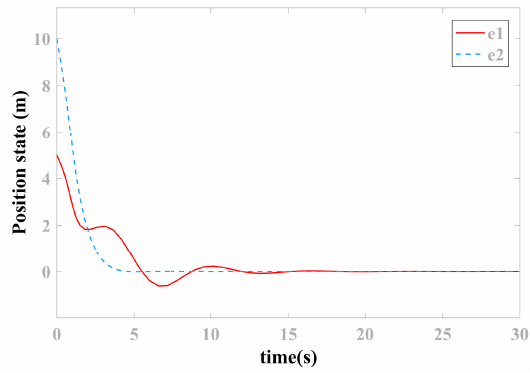
Figure 2. Sway displacement state of two ships ( e 1, e 2 )